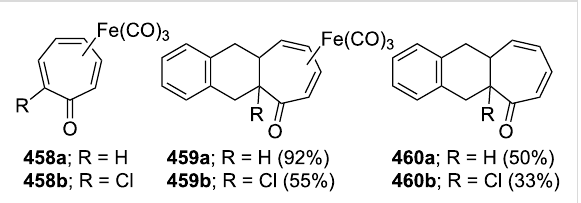
Figure 29: Structures of tricarbonyl(tropone)irons 458 , and possible cycloadducts 459 .